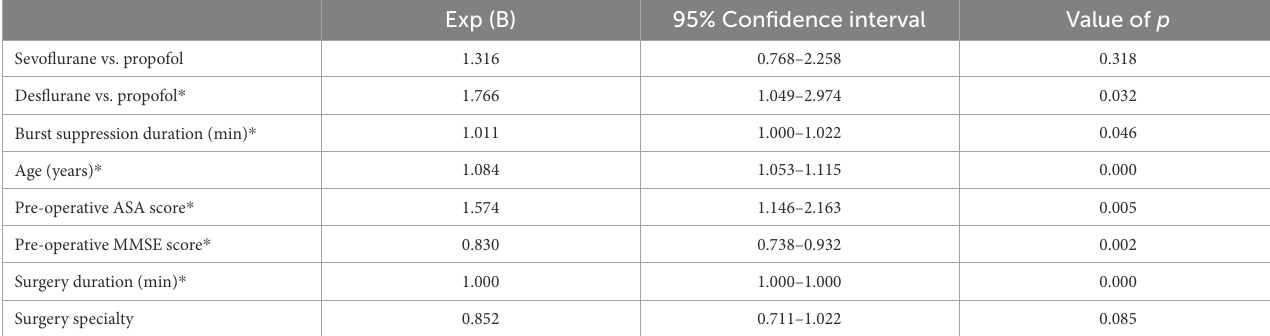
TABLE 3 Binominal logistic regression analyzing the impact on postoperative delirium (POD), including the anesthetic agent given (propofol vs. sevoflurane and propofol vs. desflurane), burst suppression duration (min), age (years), ASA status (I, II, III, IV), MMSE score (25–30), surgery duration (min), and surgery specialty (general surgery, orthopedics, urology, gynecology,